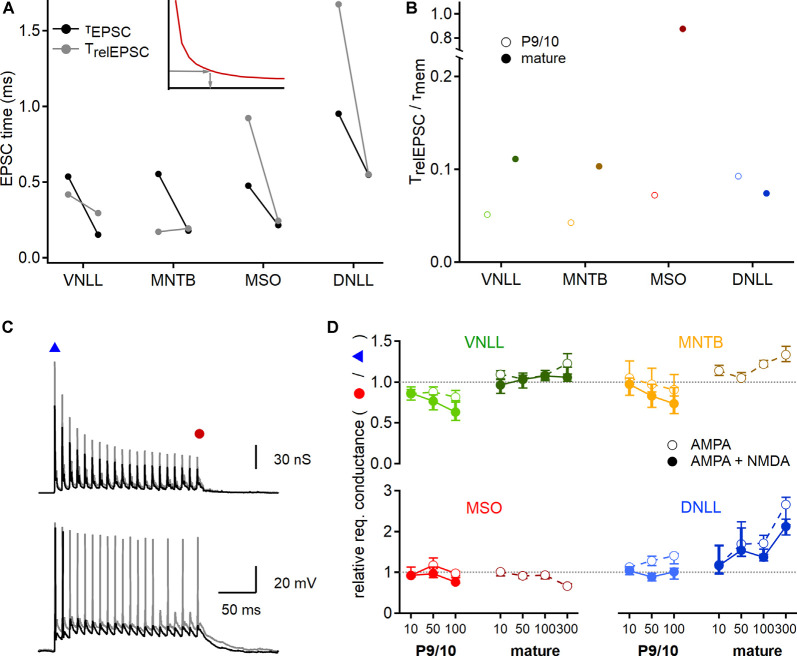
Developmental maturation of postsynaptic integration. (A) EPSC time that is integrated to generate an action potential at the conductance threshold. Inset: The relevant EPSC time (TrelEPSC; gray arrows) was estimated from strength-duration curves (red curve), by using the conductance leading to an onset action potential (y-axis) to extract the required stimulation time (x-axis). Black symbols show median values of P9/10 (left) and mature (right) fast decay values directly measured from EPSCs (τEPSC), used to predict input numbers in Figures 4, 7. Gray symbols point to the relevant EPSC time (TrelEPSC) required to elicit onset action potentials at the conductance threshold, based on recordings shown in Figure 7. (B) Ratio of TrelEPSC to τmem of young (open symbols) and mature (filled symbols) neurons for all nuclei tested. (C) EPSG templates (top) were increased to probe conductance thresholds of voltage responses (bottom) at the beginning and the end of the stimulation train. Smaller EPSG generated a single onset action potential (black trace, blue triangle), larger EPSG lead to nearly ongoing action potential generation (gray trace, red circle). (D) Ratio of required EPSG peak conductance of last stimulation pulse to onset stimulation pulse for all nuclei and age groups (P9/10: left, mature: right) and at different stimulation frequencies (10, 50, 100 Hz, and 300 Hz for mature neurons). Responses based on AMPAR and NMDAR EPSGs are shown in filled symbols, for AMPAR EPSGs in open symbols. A value above 1 (dotted lines) indicates an increased conductance requirement for steady-state action potential generation. Data are shown as median and first and third quartiles. Cell numbers per nucleus and age group as in Figure 7. Nuclei color-coded as in Figure 2.